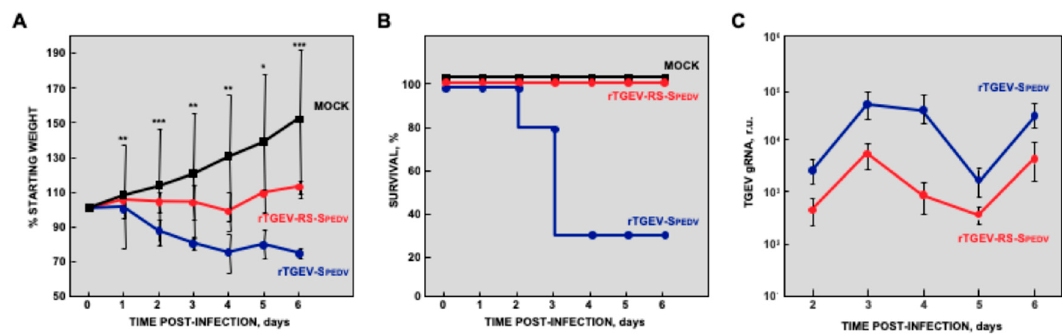
Figure 3. Virulence of rTGEV-SPEDV viruses in suckling piglets. Five-day-old piglets were orally inoculated with 10 6 TCID 50 / piglet. Animals were mock infected (mock, black) or infected with rTGEV-SPEDV (blue) or rTGEV-RS-SPEDV (red) viruses. Clinical signs were observed daily. Weight loss ( A ) and survival ( B ) are represented. The values are the mean from nine independent animals. ( C ) Virus load in feces was evaluated by RT-qPCR. Error bars represent the standard deviation for each value; p values, * < 0.05, ** < 0.01, *** <0.001.